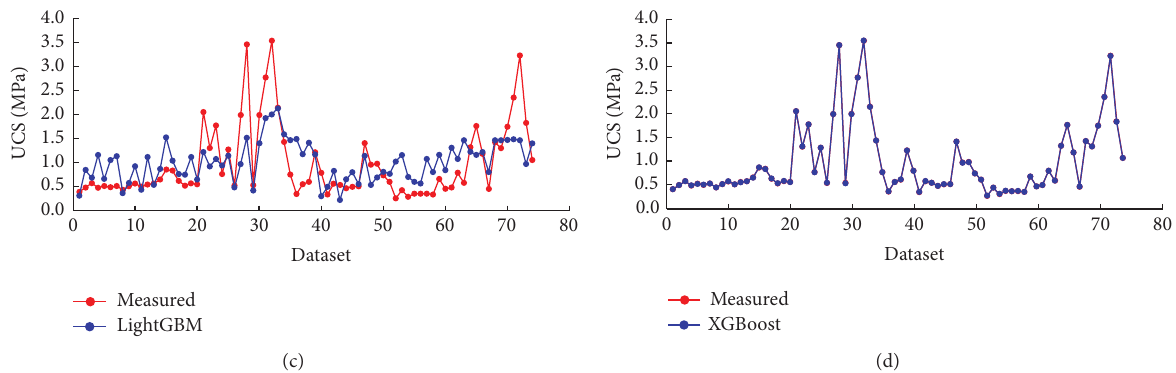
Figure 11: Performance plots of predicted UCS as opposed to measured UCS in the training stage phase: (a) GBR, (b) Catboost, (c) LightGBM, and (d) XGBoost.